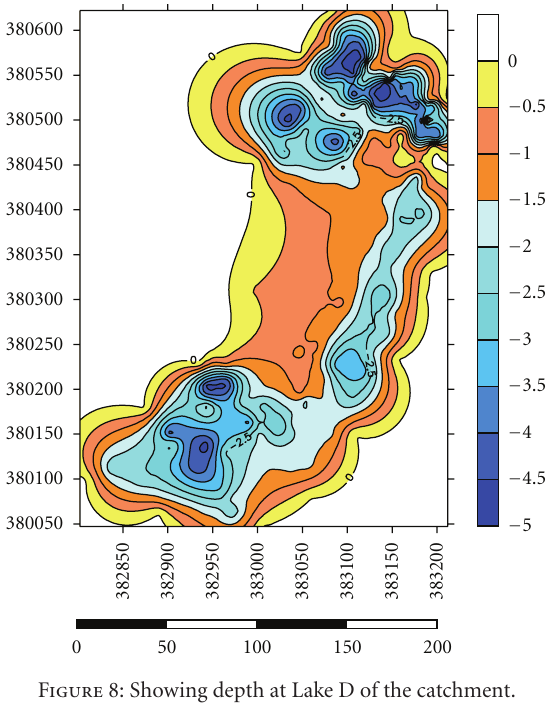
Figure 8: Showing depth at Lake D of the catchment.